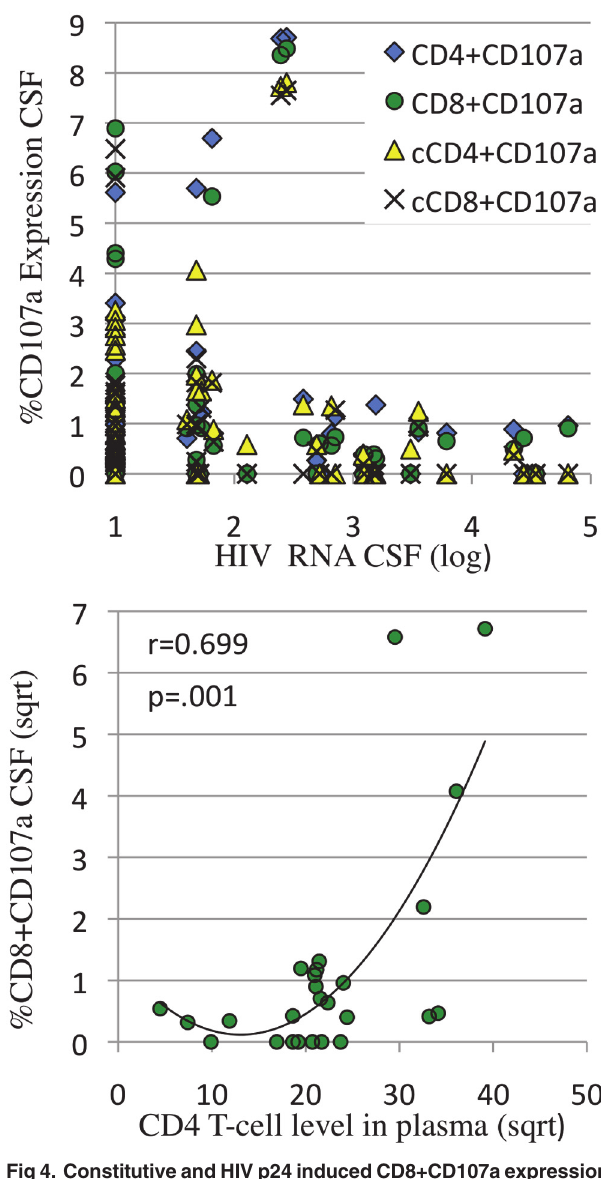
Fig 4. Constitutive and HIV p24 induced CD8+CD107a expression (lytic activity) in CSF and peripheral blood were only detected when HIV RNA levels were < 1000 copies/ml and CD4 levels were > 400/ μ l. a: The percentage of HIV p24 induced CD4+ (solid diamond) and CD8 (open circle) and constitutive (cCD107a) CD4+ (open triangle) and CD8+ (x) expression in CSF were plotted as a function of log HIV RNA in CSF. CD107a expression > 1% was only detected when HIV RNA was < 1000 copies/ml. b: The percentage of constitutive CD8+CD107a+ in CSF was plotted as a function of plasma CD4 levels. CD8+CD107a expression > 1% was detected when CD4 levels were > 400/ μ l. Cytokine expression and CD4 levels were square root